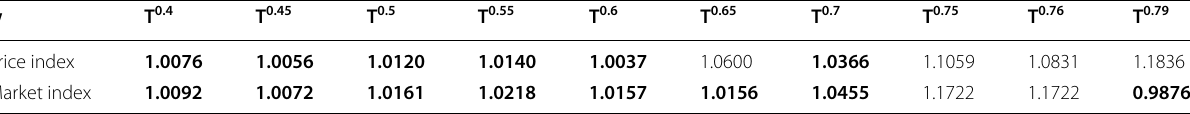
w and T are the bandwidth number and the total number of observations, respectively. Values in bold are those cases where the d estimates are not significantly different from 1